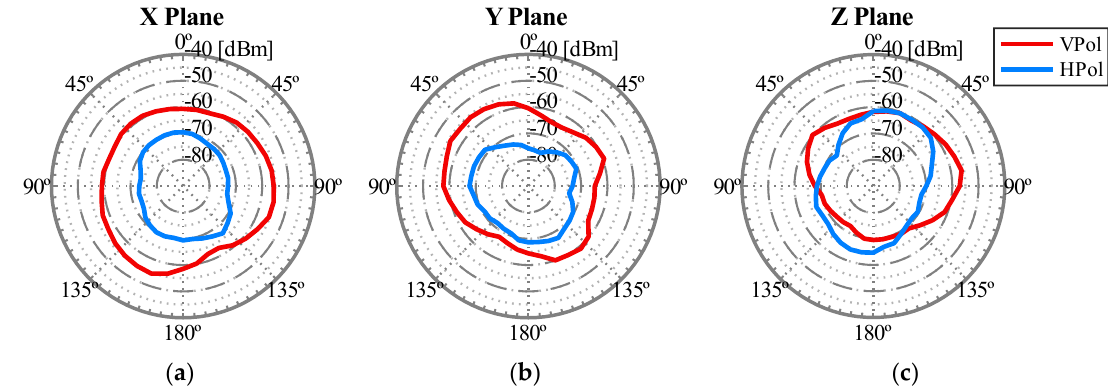
Figure 15. Radiation pattern of the isolated WiTi using the antennas configuration shown in Figure 13 in the U2U link working in 5 GHz: ( a ) X Plane, ( b ) Y Plane, and ( c ) Z Plane.